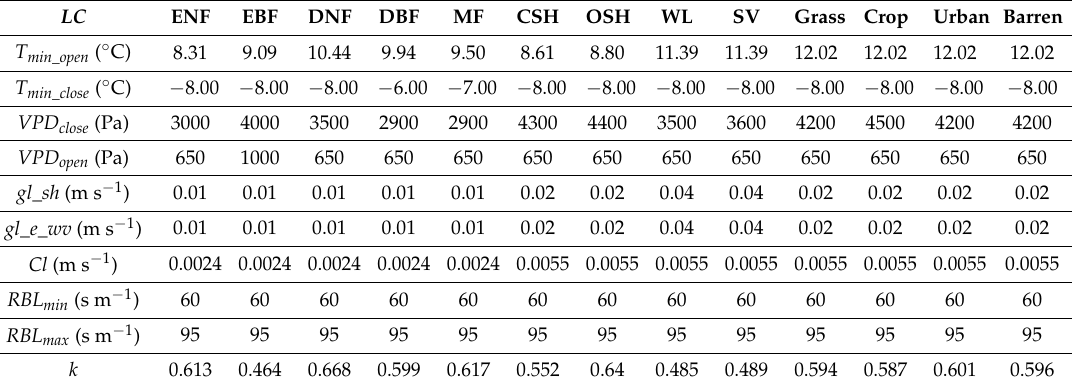
0.0024 0.0024 0.0024 0.0024 0.0024 0.0055 0.0055 0.0055 0.0055 0.0055 0.0055 0.0055